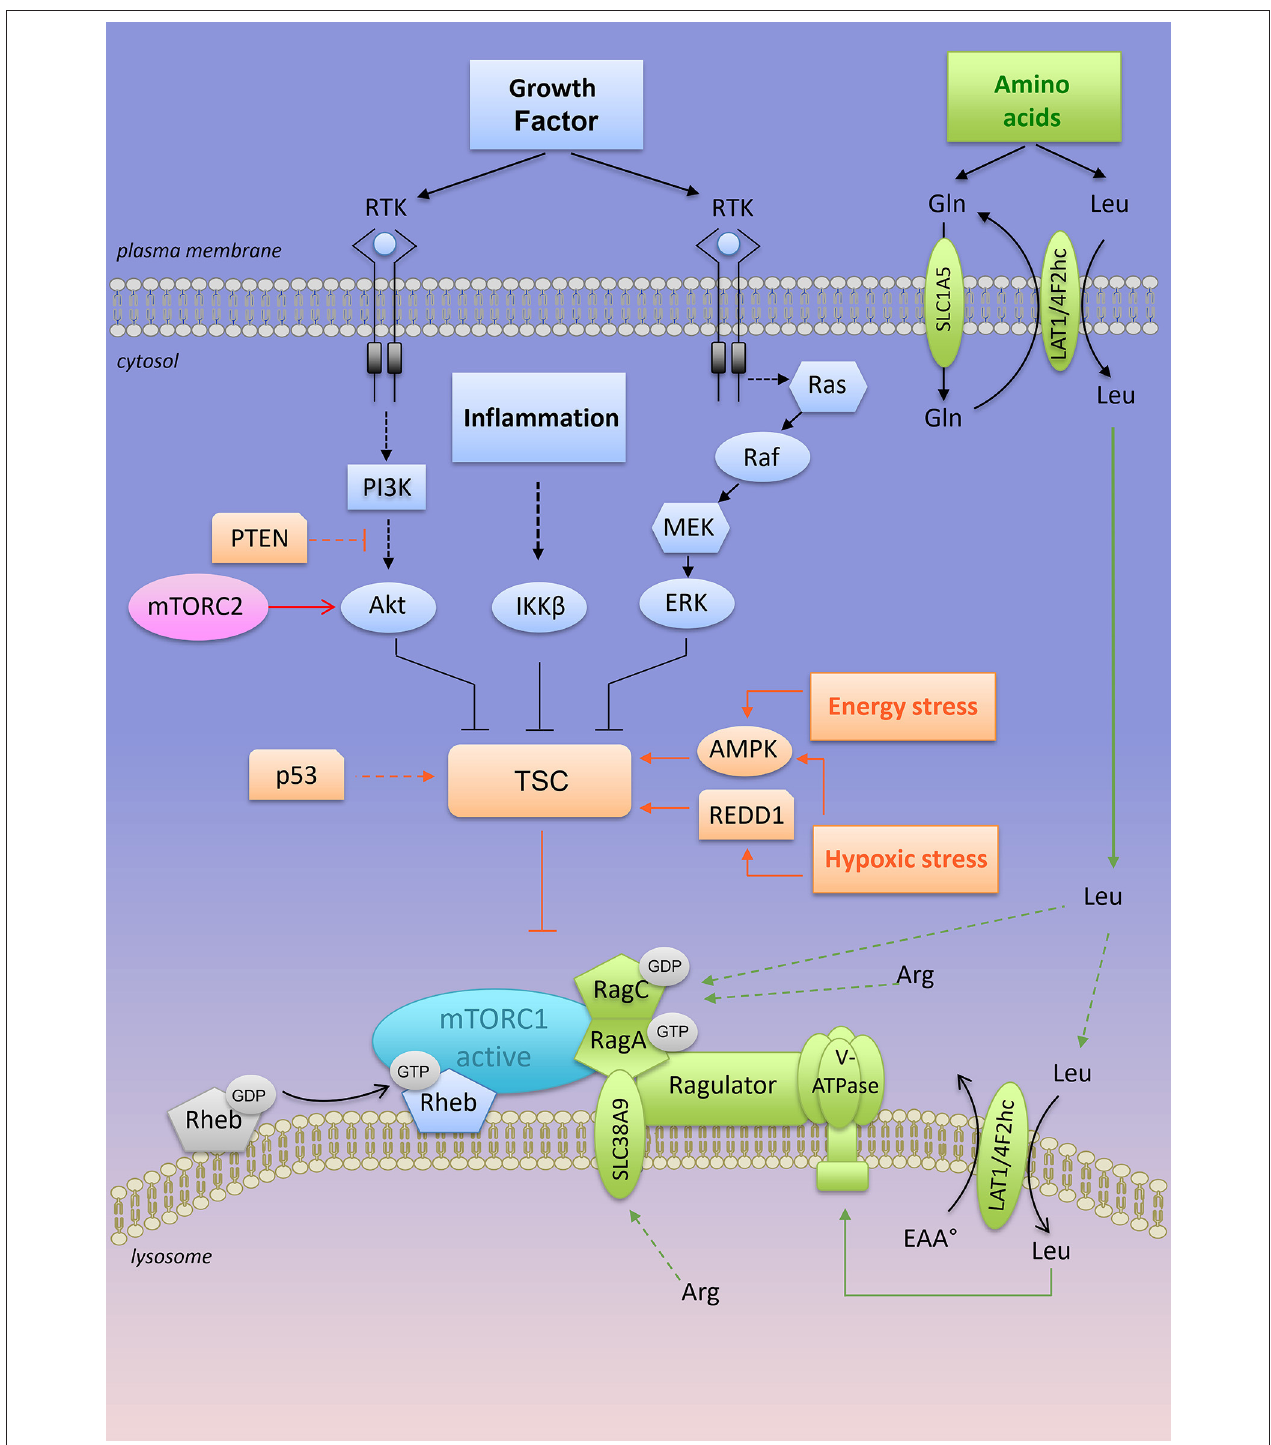
FIGURE 3 | Lysosomal “inside-out” activation of mTORC1. Both growth factors and amino acids are required for a full activation of mTORC1 at the lysosome. Positive regulators of mTORC1 are shown in blue (when activated by growth factors) and in green when activated by amino acids). RTK, receptor tyrosine kinase; mTORC1, mTOR complex 1; mTORC2, mTOR complex 2; TSC, tuberous sclerosis complex; PTEN, Phosphatase and TENsin homolog; AMPK, AMP-activated protein kinase; REDD1, Regulated in DNA damage and development 1; Rheb-GTPase, Ras homology enriched in brain-GTPase; Rag, Ras-related GTP-binding protein; LAT1, L-type amino acid transporter 1; 4F2hc, CD98 heavy subunit protein; Gln, glutamine; Leu, leucine; Arg, arginine.